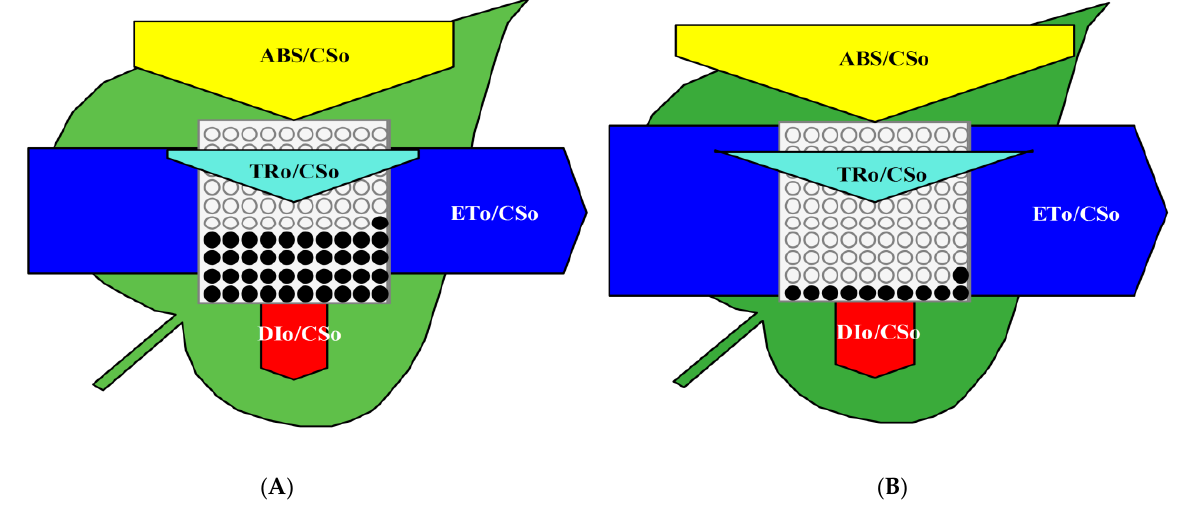
Figure 5. Phenomenological leaf model of leaves from non-inoculated ( A ) AMF ( − ) and inoculated plants ( B ) AMF (+) of soybean. Each relative value is represented by the size of the proper parameters (arrow), empty circles represent reducing QA reaction centres (active), and full black circles represent non-reducing QA reaction centres (inactive or silent). Efficiency of light absorption (ABS/CS O ), trapping (TR O /CS O ), and electron transport (ETo/CS O ) and dissipation per cross-section of PSII (DI O /CS O ) (phenomenologically per excited cross-section (CS) area).